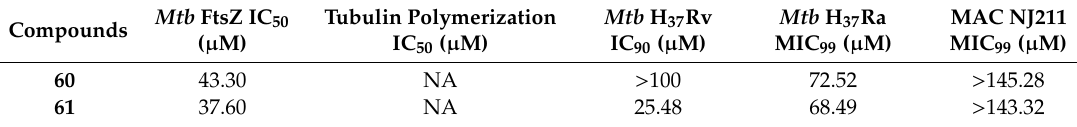
Figure 12. Chemical structures of the indene, indole, and benzimidazole derivatives. Table 12. Biological evaluation of indenes 60 and 61 .